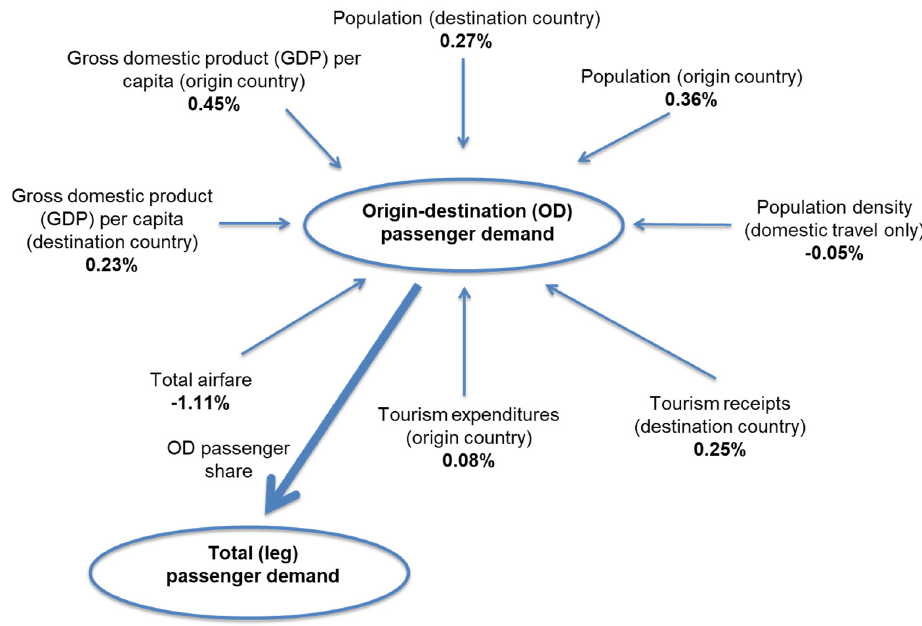
Figure 2. Major elasticities of the unconstrained passenger demand volume model [own illustration].